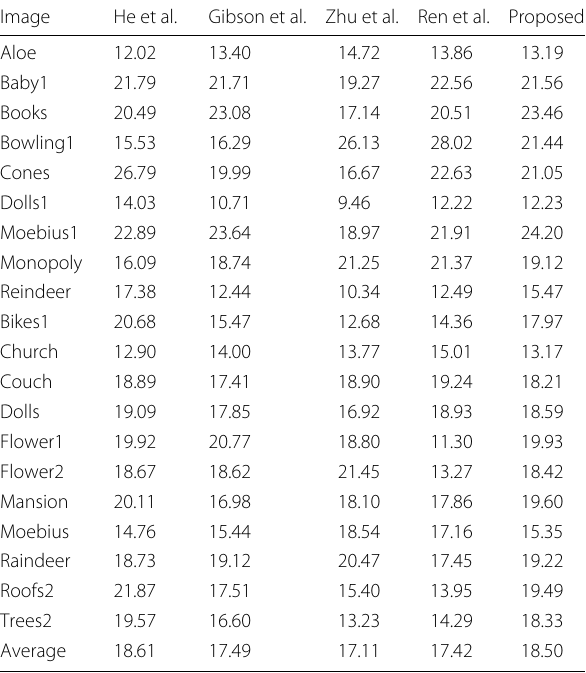
Table 3 Comparative analysis using the peak signal-to-noise ratio (PSNR) (in Db) Image He et al.